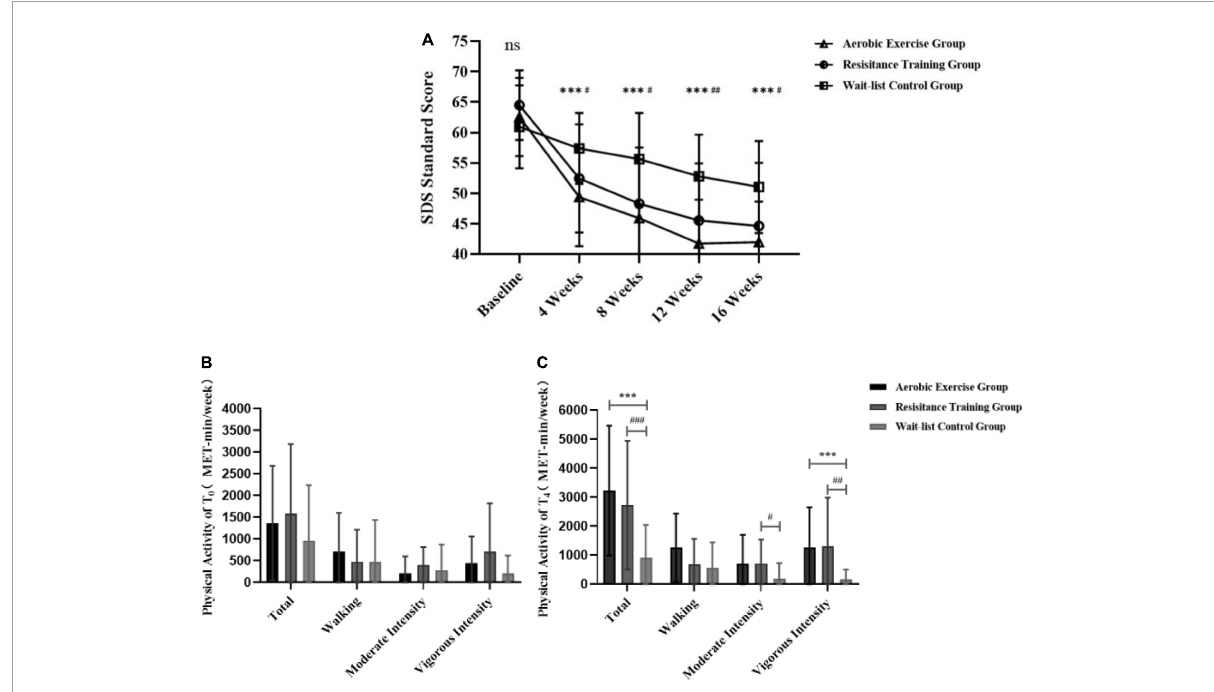
FIGURE2 Comparison of between-group differences in depression state and physical activity (continuous) for AE, RT, and WLC groups. (A) The between-group differences for SDS standard scores. (B) Baseline PA differences by intensity. (C) PA intensity differences 4 weeks after intervention. ns Represents no significant difference among the three groups in time point. ∗∗∗ Represents a significant difference between the AE group and the WLC grou p in time point. # Represents a significant difference between the RT group and the WLC group in time point. ∗∗∗ p < 0.001; # p < 0.05, ## p < 0.01, and ### p <